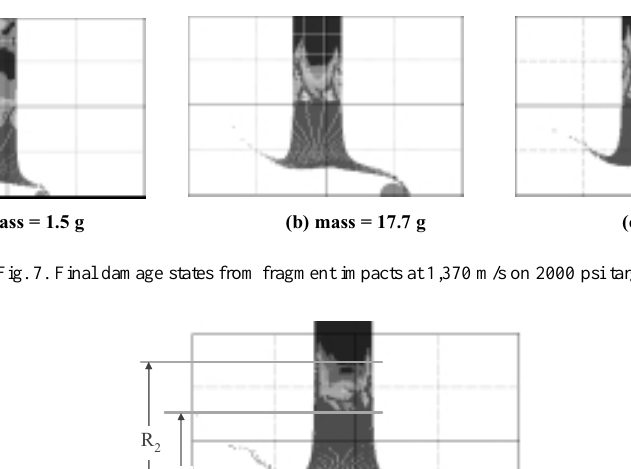
Fig. 6. Residual velocity for fragments impacting 2,000 psi concrete shell.